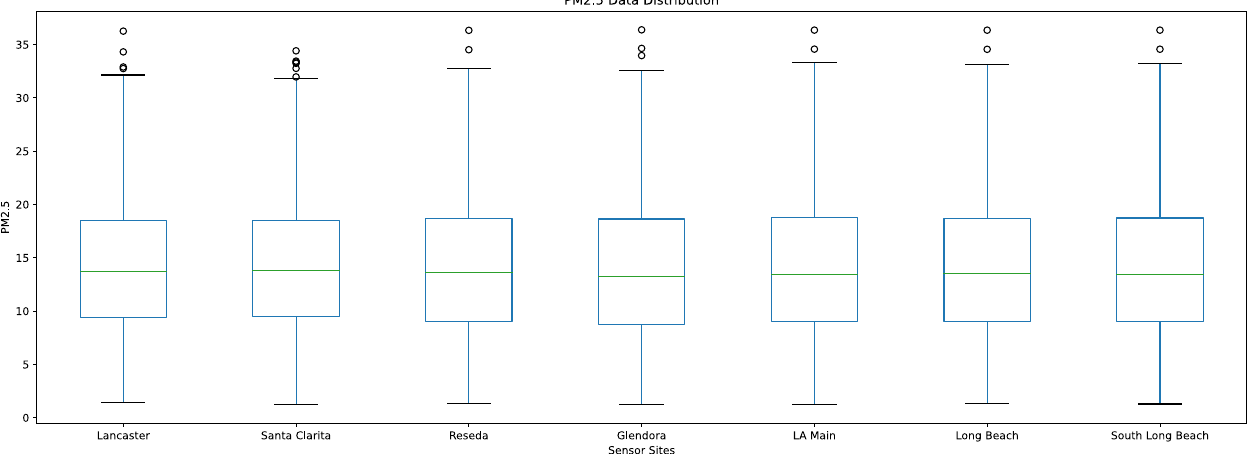
Figure 12. Data Distribution Plot of PM2.5 Ground Truth Sensors in LA County during Testing